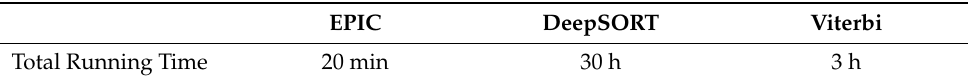
Table 2. Total runtimes for EPIC, DeepSORT and Viterbi in the 9 experiments. EPIC